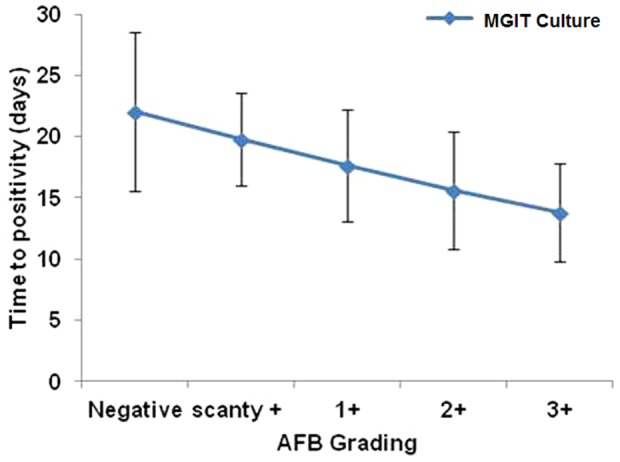
Time to positivity (TTP) in liquid cultures and its correlation with smear positivity.